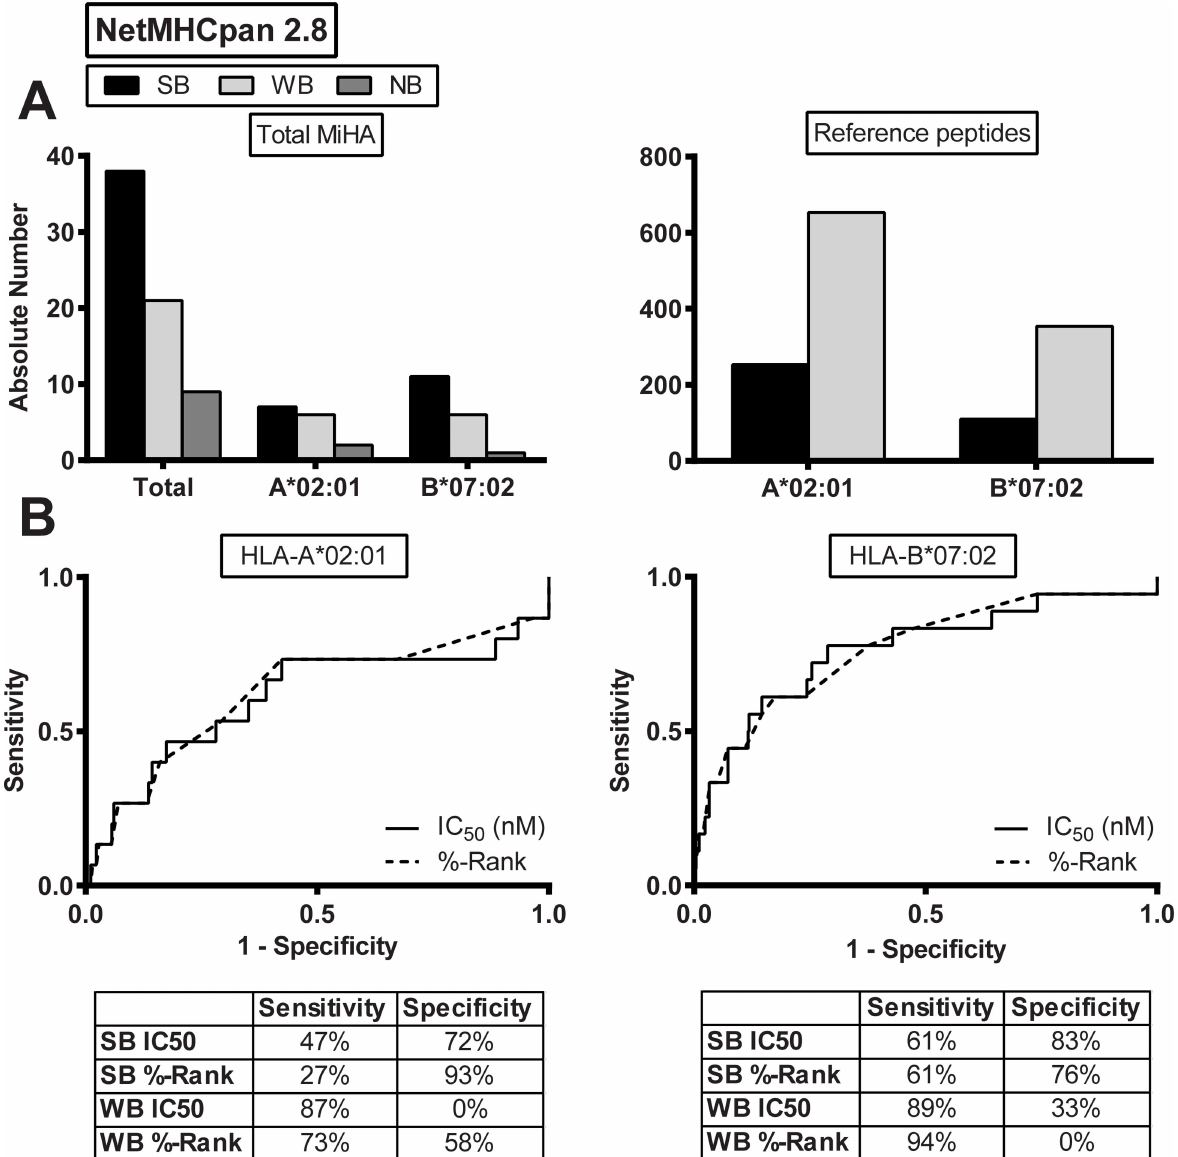
Fig 1. Predicted HLA class I bindingaffinity. (A) HLA class I bindingaffinityas predictedby NetMHCpan 2.8 for MiHA that have been identifiedas naturalT-cell ligandsby forward strategies.Results are shown for the total group of MiHA (n = 68) and for HLA-A * 02:01-restrictedMiHA (n = 15) and HLA-B * 07:02-restricted MiHA (n = 18) (left)as comparedto reference peptideswith predictedbindingaffinityto HLA-A * 02:01(n = 906) or HLA-B * 07:02(n = 464) (right).Indicated are absolutenumbers of peptideswith strongpredictedbinding(SB; black bars),weak predictedbinding(WB;light grey bars) and non-binding (NB; darkgrey bars).Thedata show that the proportionof SB peptidesin the group of MiHA is higherthan in the referenceset of peptides(54% versus 28% with p = 0.0581for HLA-A * 02:01;65% versus 24% with p = 0.0005for HLA-B * 07:02 using Fisher’s exact test).(B) ROC curves for HLA class I bindingaffinityas predictedby NetMHCpan 2.8 for HLA-A * 02:01(left)and HLA-B * 07:02 (right).Sensitivity and 1-specificityare shown on the Y- and X-axis, respectively. Curvesfor IC 50 (solid line)and %-Rank(dashedline) are plottedbased on predictiondata for MiHA and reference peptides. Sensitivityand specificityare indicatedfor default values for SB ( (cid:20) 0.5%-Rank or IC 50 (cid:20) 50 nM) and WB ( (cid:20) 2%- Rank or IC 50 (cid:20) 500 nM).For HLA-A * 02:01,AUC values for %-Rankand IC 50 are 0.625 and 0.609,respectively (p = 0.0964for %-Rank; p = 0.1486for IC 50 ). For HLA-B * 07:02, AUC values for %-Rankand IC 50 are 0.767and 0.765,respectively (p = 0.0001for %-Rank; p = 0.0001for IC 50